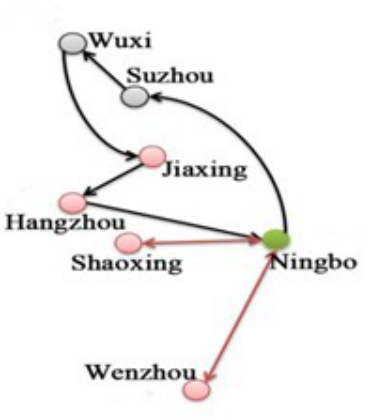
Figure 4. The optimization results of Ningbo origin